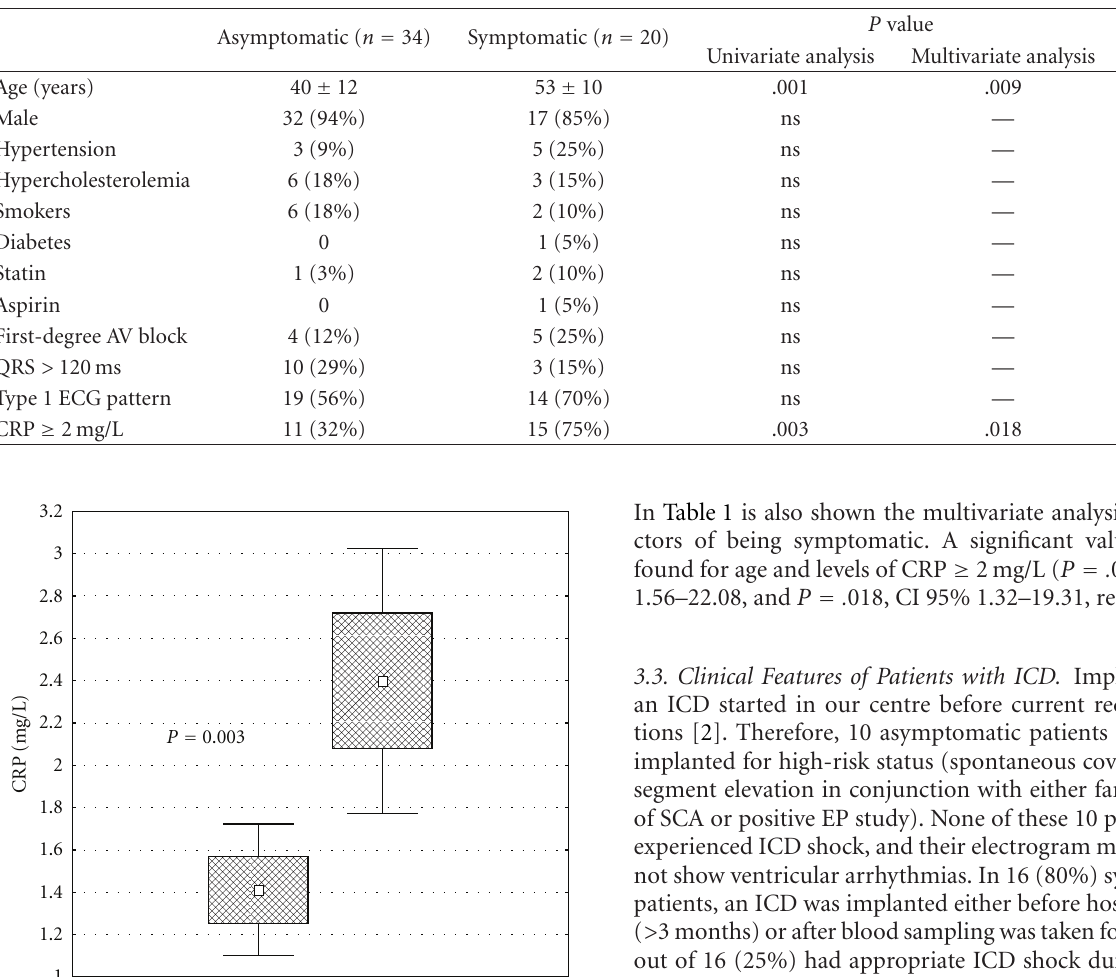
Table 1: Baseline characteristics of asymptomatic and symptomatic BrS patients.